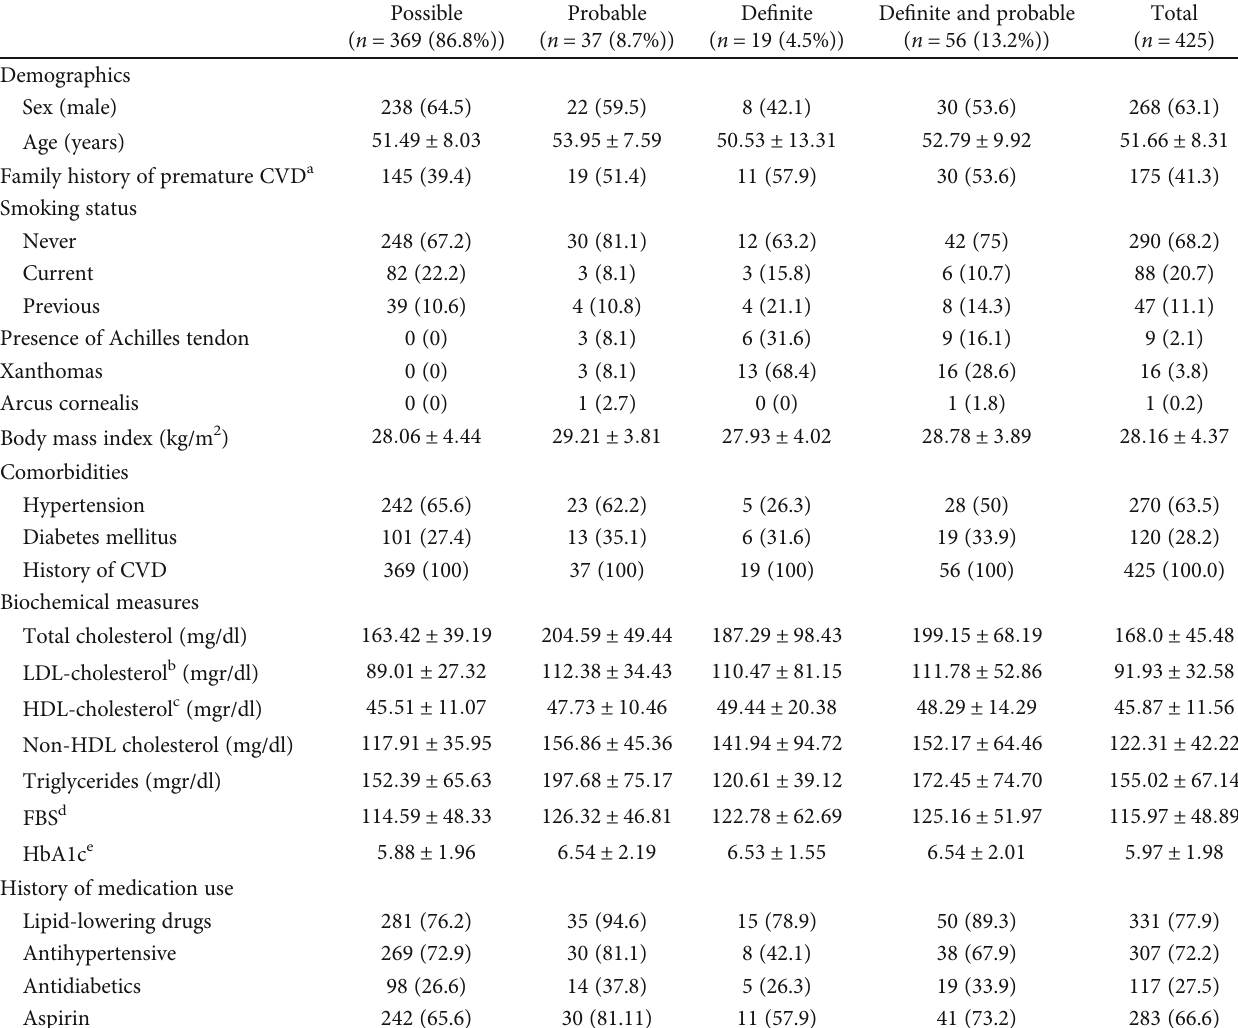
Table 2: Baseline characteristics of patients with premature coronary heart disease and familial hypercholesterolemia, by Dutch Lipid Clinic Network